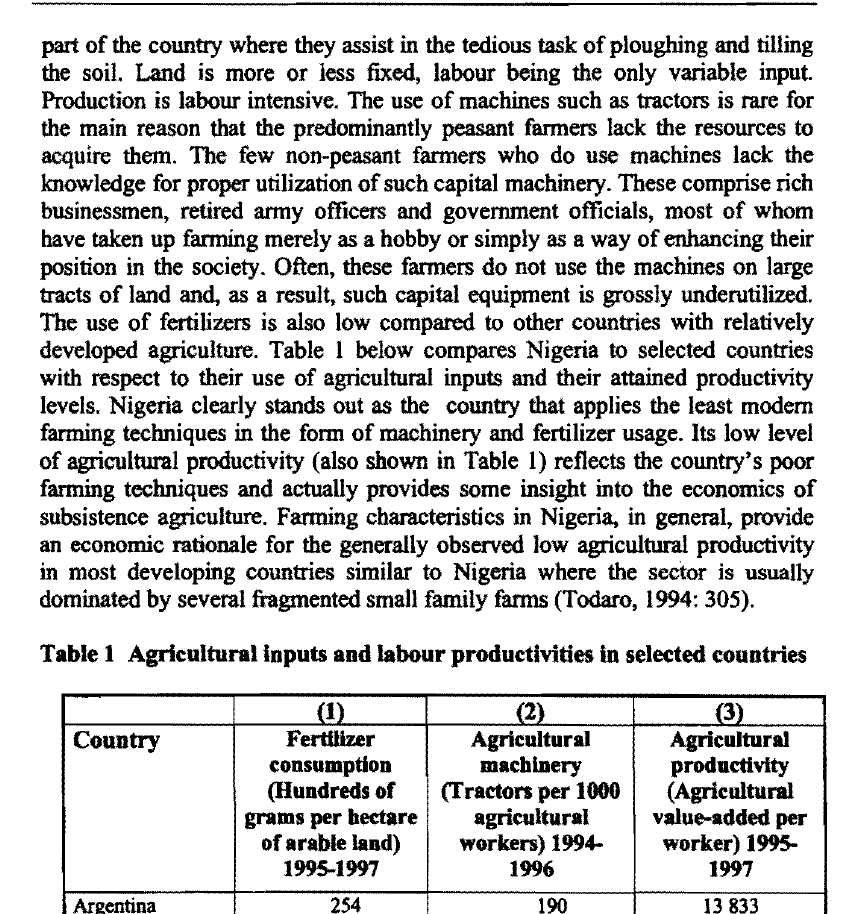
Table 1 Agricultural inputs and labour produdivities in selected countries (1) (2)